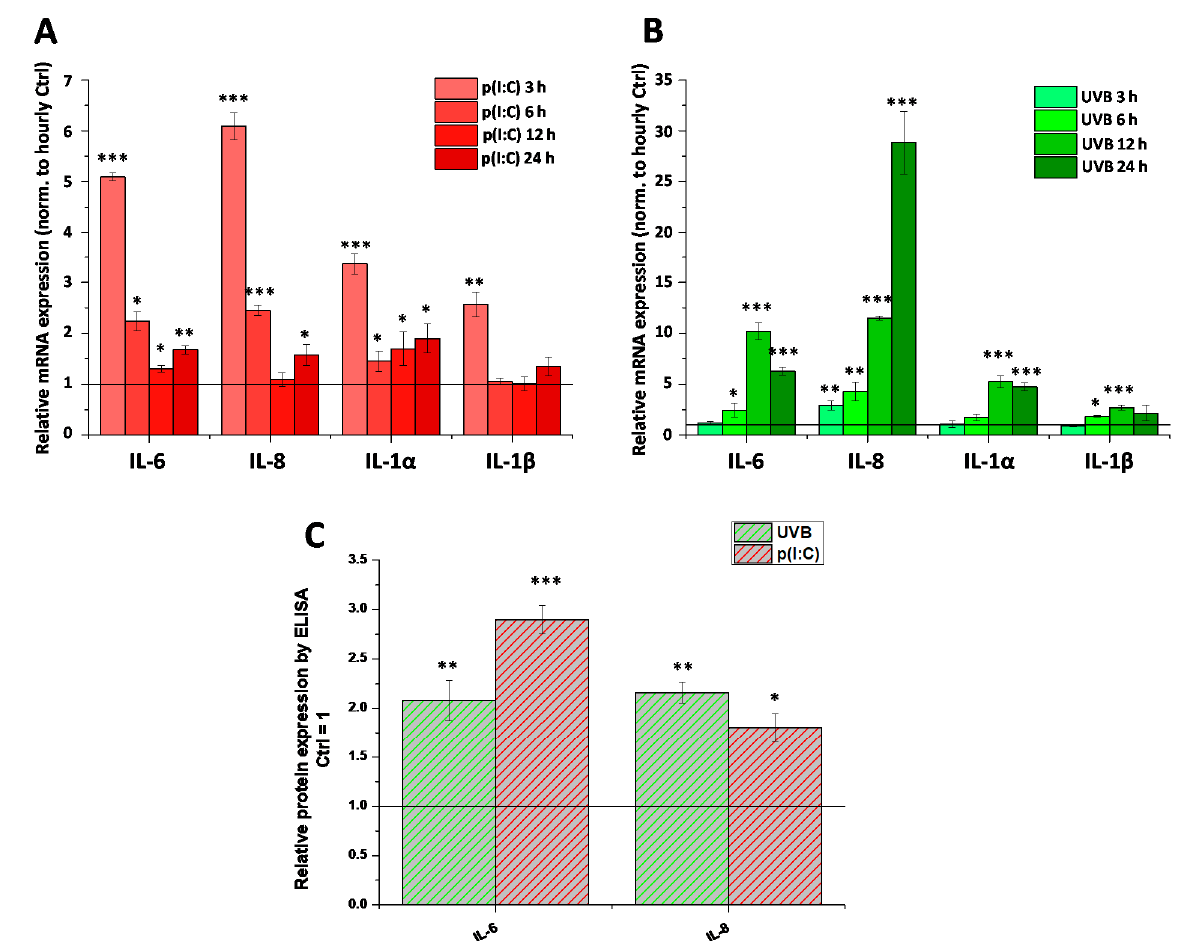
Figure 3. Inflammation can be induced in human corneal epithelial cells by both TLR3 activation and UVB irradiation: ( A , B ) Q-PCR of IL-6, IL-8, IL-1 α , and IL-1 β mRNA from cultured human corneal epithelial cells. Expression was determined following 3, 6, 12, 24 h after p(I:C) treatment ( A ) and 3, 6, 12, 24 and 48 h after UVB irradiation (40 mJ/cm 2 ) ( B ). Data are presented using the ∆∆ CT method compared to 18SRNA ( A ) and PPIA ( B ), normalized to the expression of the vehicle- treated control (shown as a continuous line at 1). Data are expressed as mean ± SD of 2–3 determinations. One additional experiment yielded similar results. *, **, *** mark significant changes compared to the time-matched control group ( p < 0.05, 0.01, 0.001, respectively), as indicated. ( C ) ELISA determination of IL-6 and IL-8 in the supernatant of human corneal epithelial cells following 3 h p(I:C) and 12 h after UVB irradiation. Data are expressed as mean ± SD of three